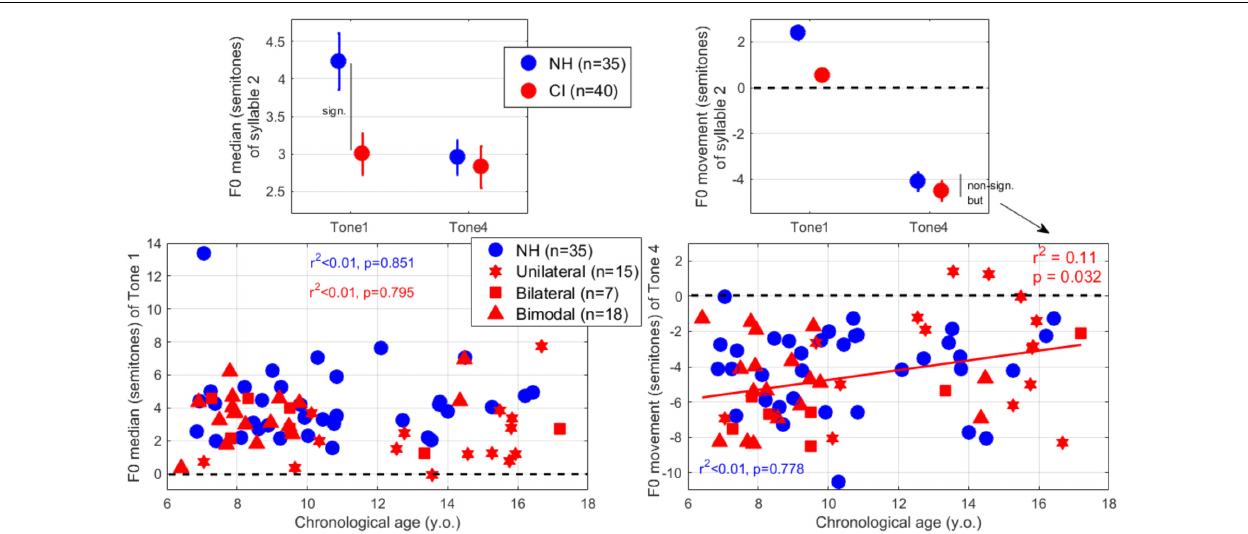
FIGURE 6 | (Top-left) F0 median over the second syllable, expressed relatively to that in the first syllable. A higher value implies the use of a higher pitch range relative to syllable 1, and is particularly relevant for Tone 1’s examination. (Top-right) F0 movement calculated as the difference between the last and first 30-ms of the F0 pattern over the second syllable only. A negative value means a falling inflection, and is particularly relevant for Tone 4’s examination. (Bottom-left) F0 median for Tone 1 and (bottom-right) F0 movement for Tone 4, plotted across participants as a function of their chronological age.